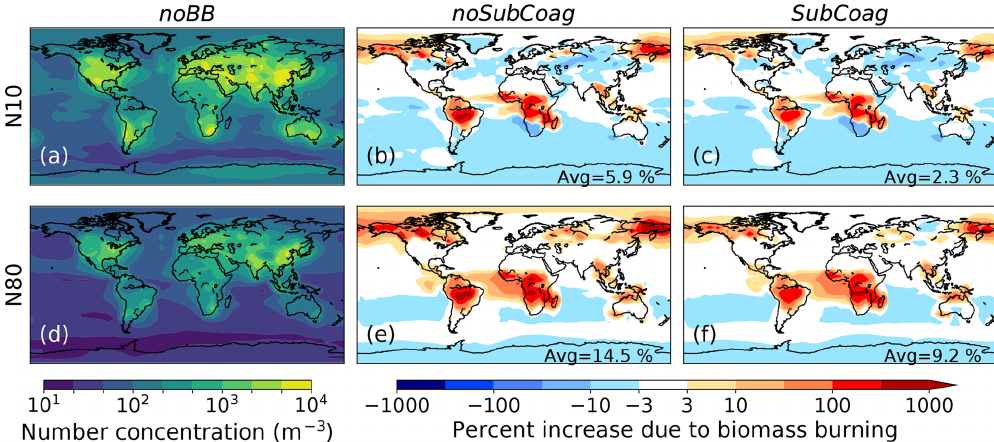
Figure 3. Effect of biomass burning on surface-level number concentration of particles larger than 10nm (a, b, c) and 80nm (d, e, f) . Panels (a) and (d) show the absolute number concentration for the noBB simulation. Panels (b) and (e) show the percent increase due to GFED biomass burning emissions from the noBB simulation to the noSubCoag simulation. Panels (c) and (f) show the percent increase due to GFED biomass burning emissions from the noBB simulation to the SubCoag simulation. The number in the bottom right of each panel is the global mean percent increase due to biomass